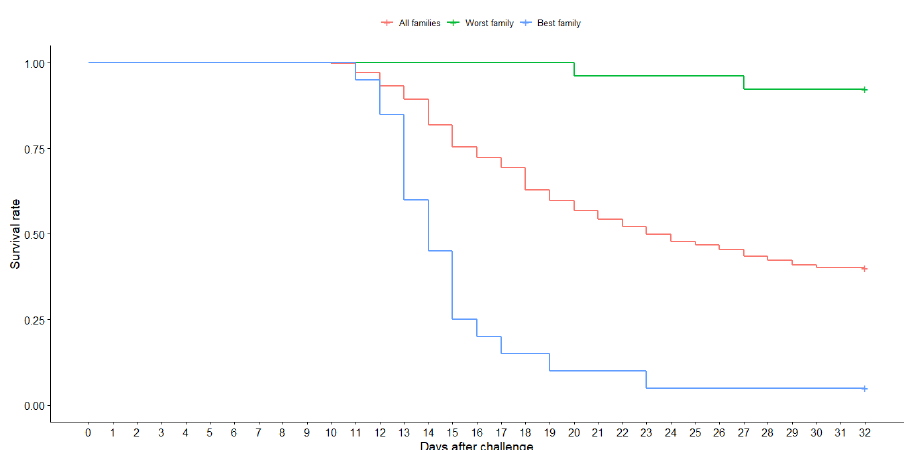
Figure 1. Kaplan–Meier survival curves of the average of the 102 full-sib families, the best and the worst family after an experimental challenge with P. salmonis in a breeding rainbow trout ( O. mykiss ) population.